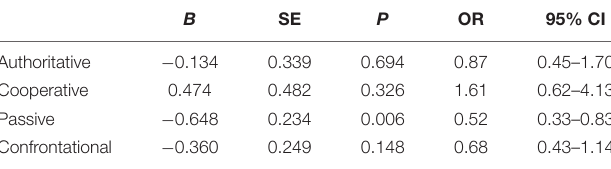
TABLE 4 | Maladaptive interviewing (case strength).